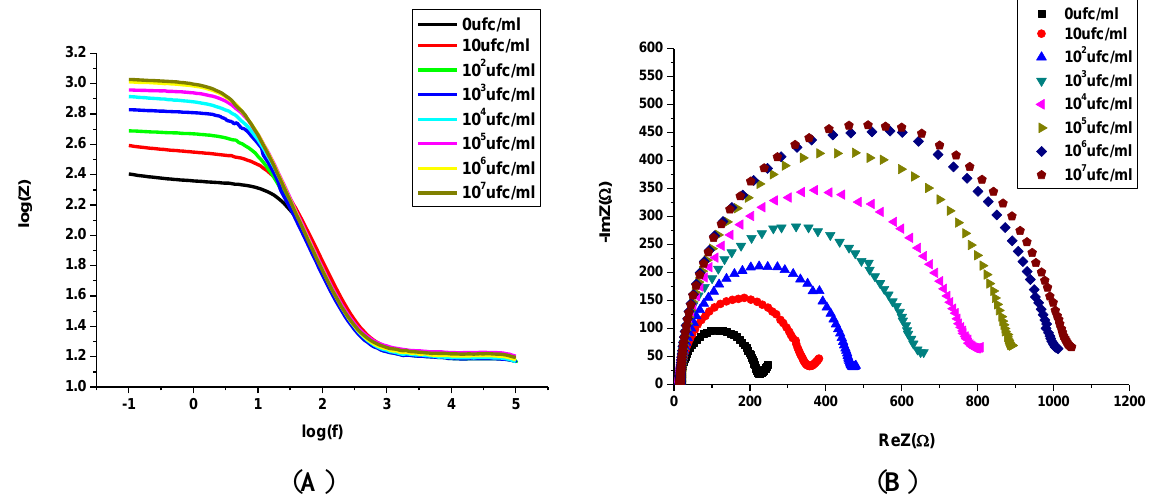
Figure 5. Electrochemical detection of ( A ) Bode plot, and ( B ) Nyquist plot of impedance spectra obtained from the increasing concentration of S. aureus (ATCC25923) from 10 to 10 7 CFU/mL in PBS and Fe(CN ) 3–/4– 6